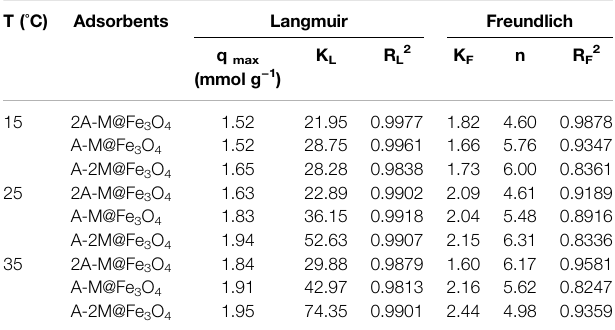
TABLE 1 | Langmuir and Freundlich isotherm parameters of bifunctional PSQ/ CNTs magnetic composites for Hg(II). T ( ° C) Adsorbents Langmuir